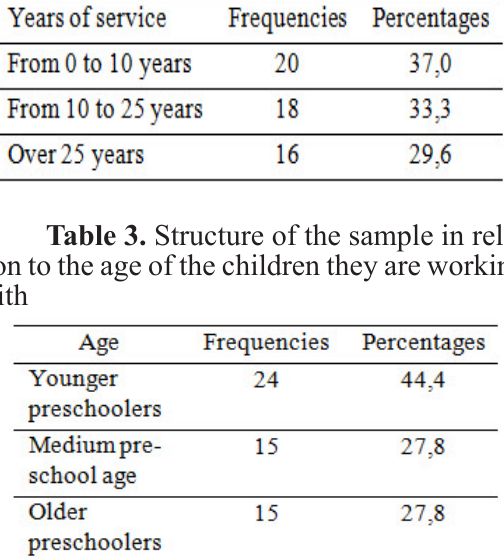
Table 2. Sample structure of preschool